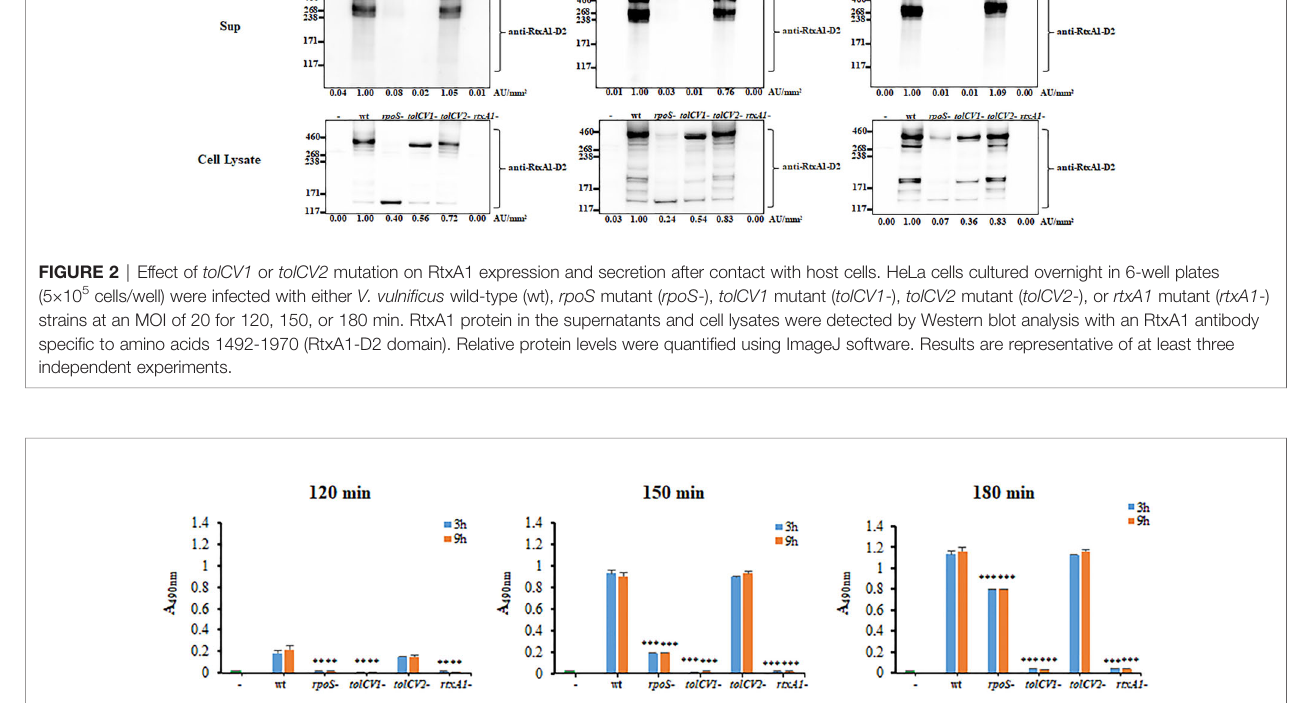
FIGURE 3 | Effect of tolCV1 or tolCV2 mutation on V. vulni fi cus cytotoxicity to host cells. HeLa cells cultured overnight in 48-well plates (5×10 4 cells/well) were infected with 3 h or 9 h cultured bacterial cells of V. vulni fi cus wild-type (wt), rpoS mutant ( rpoS -), tolCV1 mutant ( tolCV1 -), tolCV2 mutant ( tolCV2 -), or rtxA1 mutant ( rtxA1 -) strains at an MOI of 20 for 120, 150, or 180 min. The cytotoxicity of V. vulni fi cus strains was determined by measuring the amount of lactate dehydrogenase (LDH) released in the cell culture supernatants. Results are representative of at least three independent experiments. The statistical differences were analyzed by Student ’ s t-test ( *** and ** indicate P < 0.001 and P < 0.01 versus the wild-type treated group,